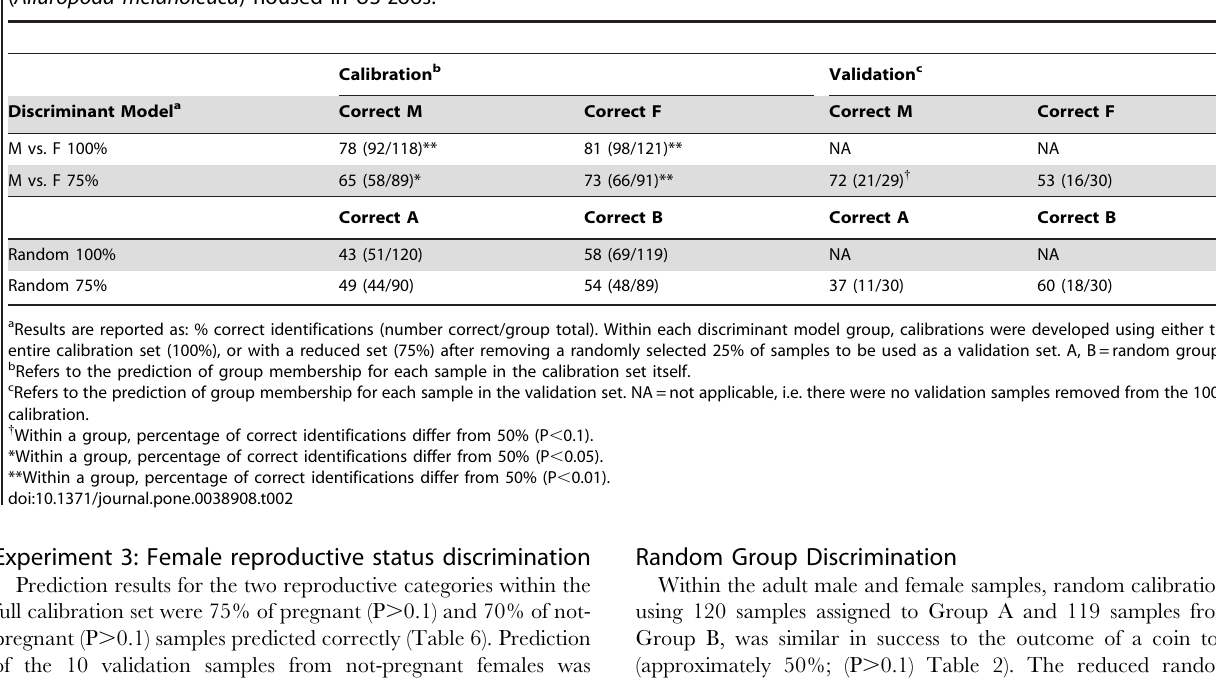
Experiment 3: Female reproductive status discrimination